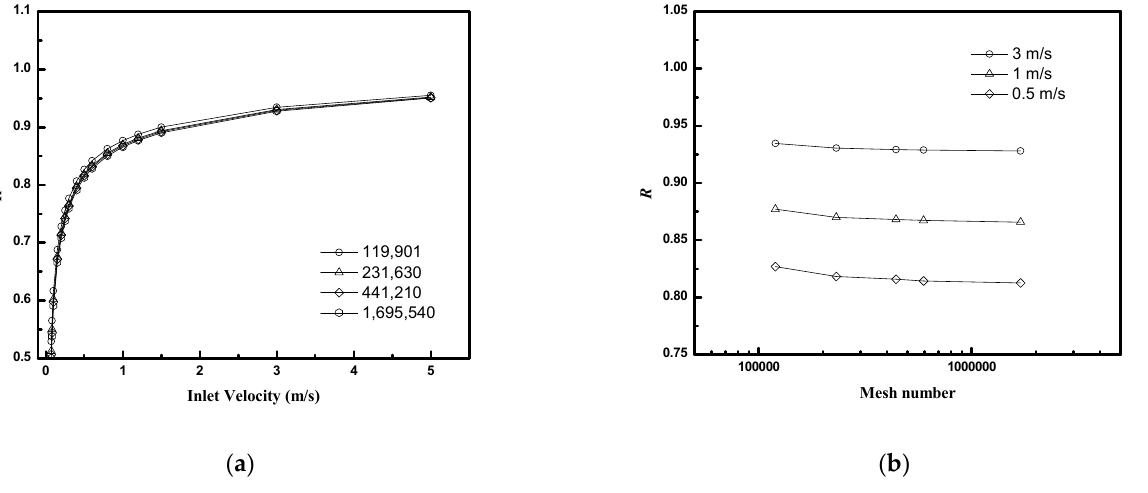
Figure 3. Mesh independence studies ( N = 16, φ = 0.4, D/R f = 4.8, planar bundle): ( a ) R as a function of inlet velocity for module with different mesh numbers ( b ) R as a function of mesh numbers for module with different inlet velocity.